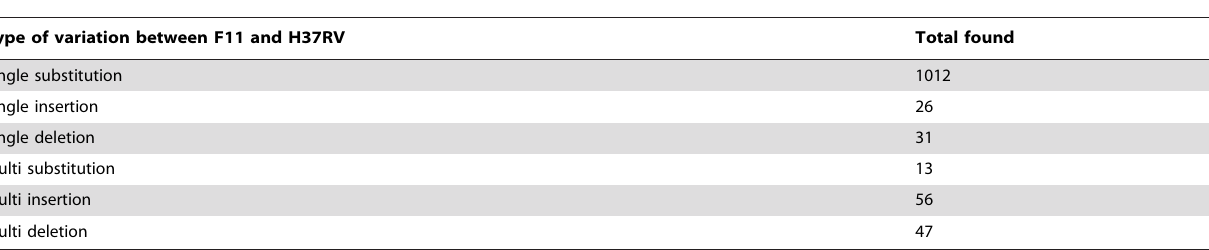
Table 2. Summary of variant types curated in the M. tuberculosis H37Rv and M. tuberculosis F11 finished genome comparison.